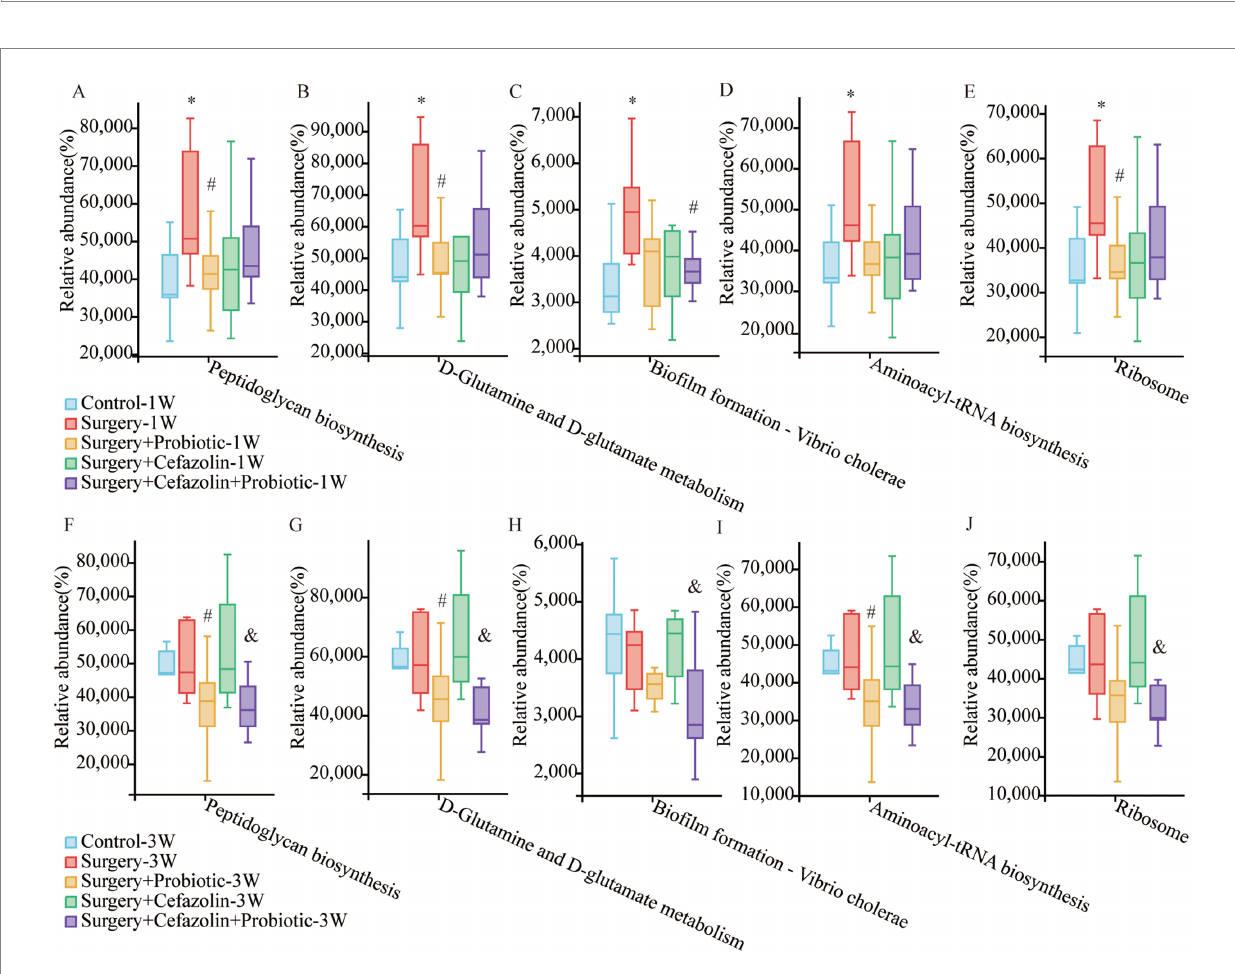
FIGURE 10 PICRUSt2 functional predictive analysis based on the Greengene database. (A–E) The relative abundance of Peptidoglycan biosynthesis, D-Glutamine and D-glutamate metabolism, Biofilm formation—Vibrio cholerae, Aminoacyl-tRNA biosynthesis, and Ribosome at postoperative 1 week among Grp CTL, Grp S, Grp SP, Grp SC, Grp SCP. (F–J) The relative abundance of Peptidoglycan biosynthesis, D-Glutamine and D-glutamate metabolism, Biofilm formation—Vibrio cholerae, Aminoacyl-tRNA biosynthesis, and Ribosome at postoperative 3 weeks among Grp CTL, Grp S, Grp SP, Grp SC, Grp SCP. Grp, group; CTL, control; S, surgery; SC, surgery combined with cefazolin; SP, surgery combined with probiotics; SCP, surgery combined with cefazolin and probiotics. *Compared with Grp CTL, p < 0.05; # compared with Grp S, p < 0.05; & compared with Grp SC, p <